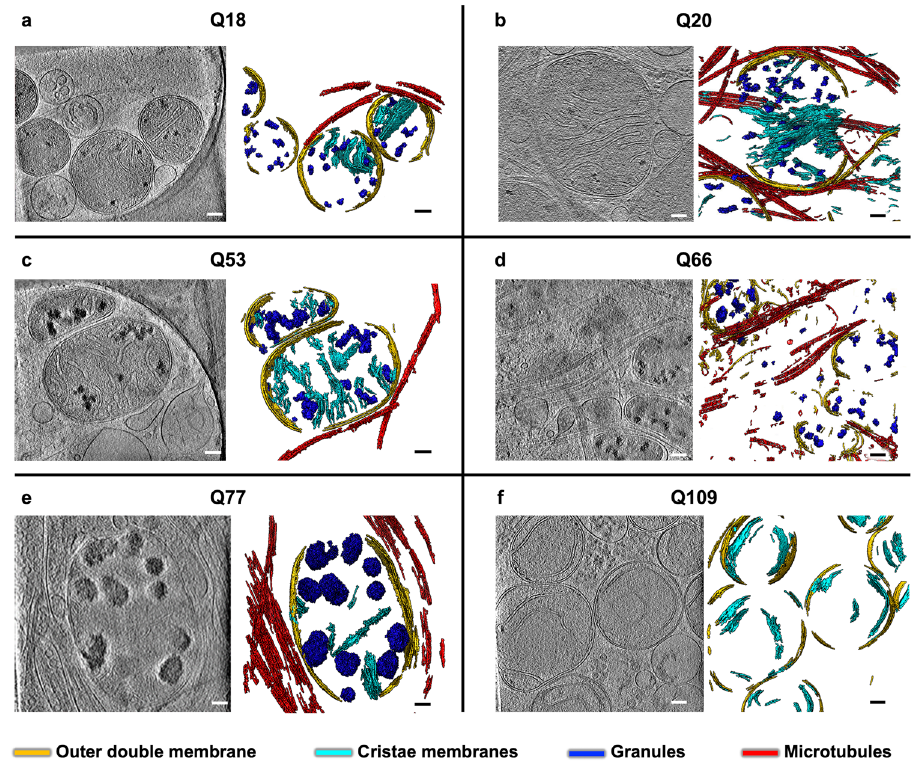
Fig. 1 | Mitochondria in neurites of HD patient iPSC-neurons exhibit altered morphology and contain enlarged granules of varying size. Slices (~1.4nm thick) through selected regions of representative cryoET tomograms and corre- sponding segmentations of local features for a Q18, b Q20, c Q53, d Q66, e Q77, and f Q109 human iPSC-neurons. For HD Qn, mitochondria have swollen cristae and contain enlarged granules compared to controls (Q18 & Q20), with